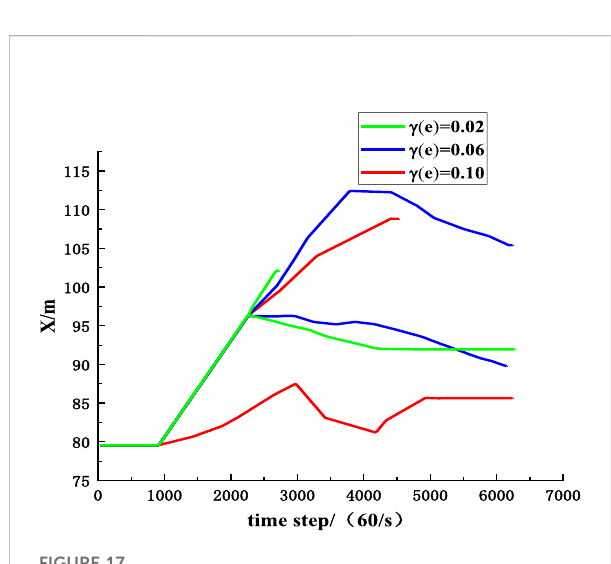
FIGURE 18 The in fl uence of randomness of friction coef fi cient on inclined position coordinates of rockfall.